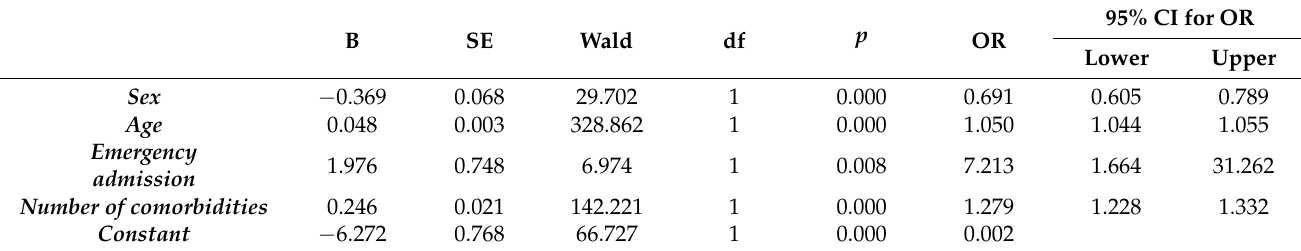
Table 3. Regression analysis of the factors that influenced disease